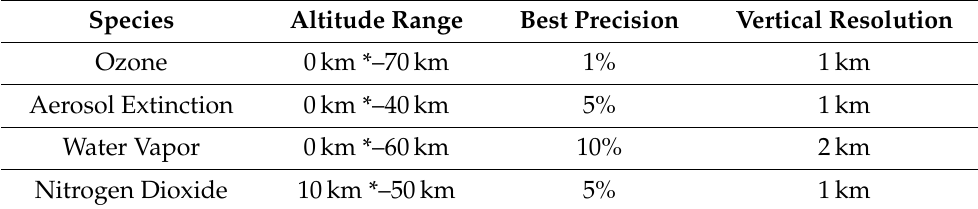
Table 1. Science